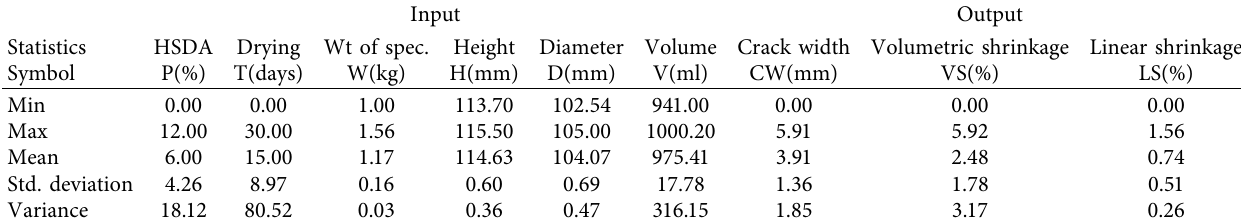
Table 1: Statistical indicators of input and output